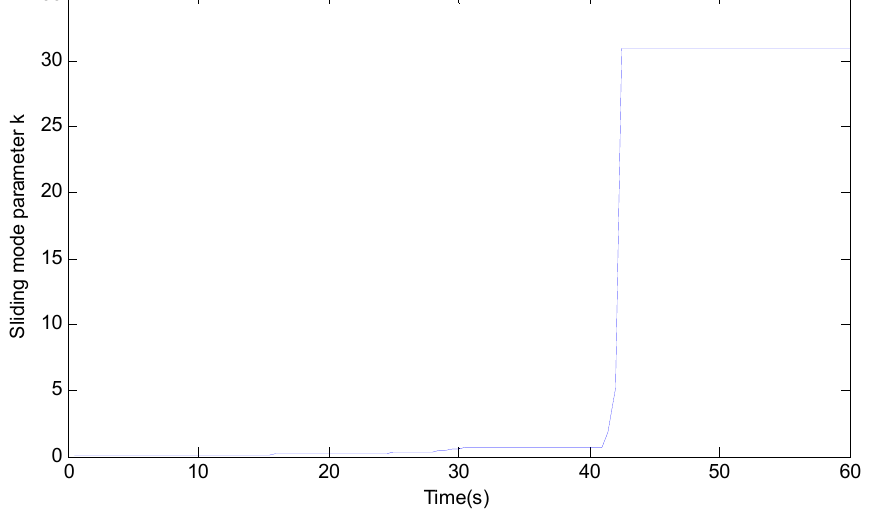
Figure 11. Curve of sliding mode parameter.